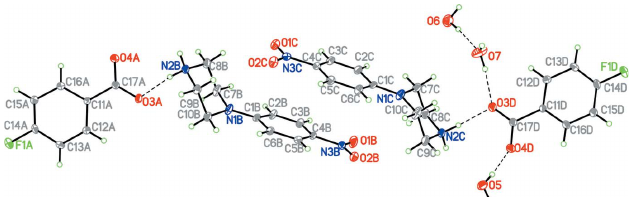
Figure 2 Diagram showing atom labelling indicating four rings A – D , the arrangement of cation and anion and the three water molecules of solvation in 2 . Hydrogen bonds are shown by dashed lines. Atomic displacement parameters are at the 30% probability